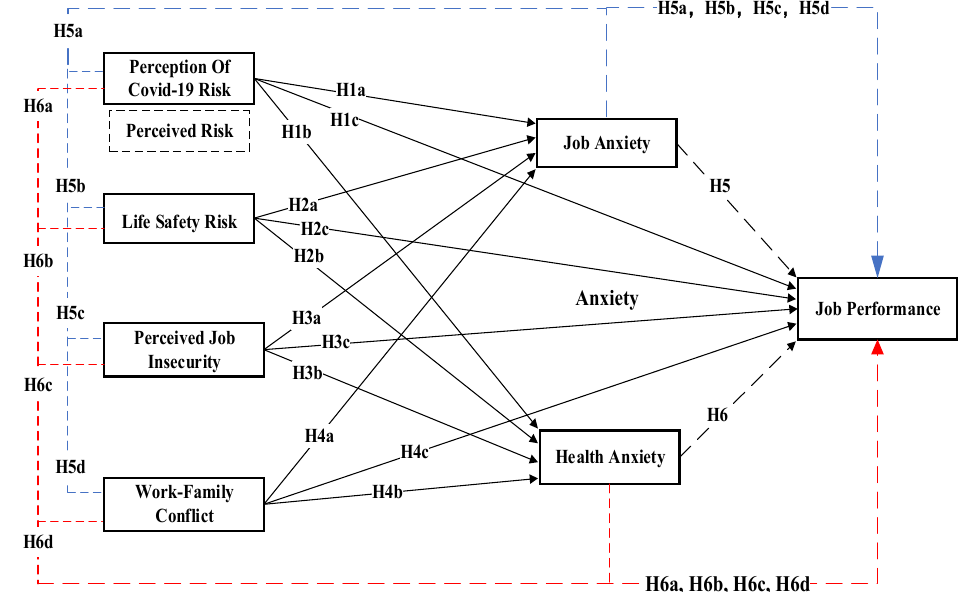
Figure 1. Conceptual framework. POCR—perception of COVID-19 risk; LSR—life-safety risk; PJI— perceived job insecurity; WFC—work–family conflict; JA—job anxiety; HA—health anxiety; JP—job performance.